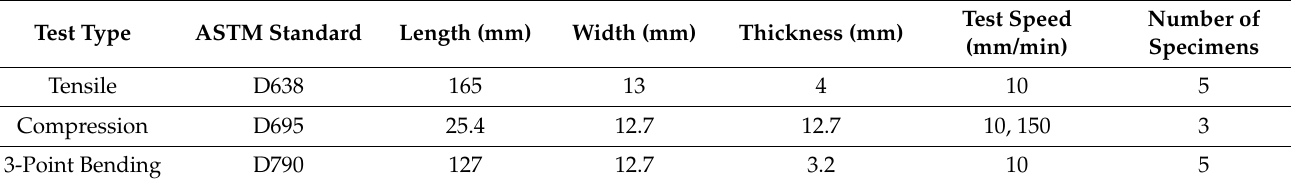
Table 2. Standards used for mechanical tests and specimen dimensions.